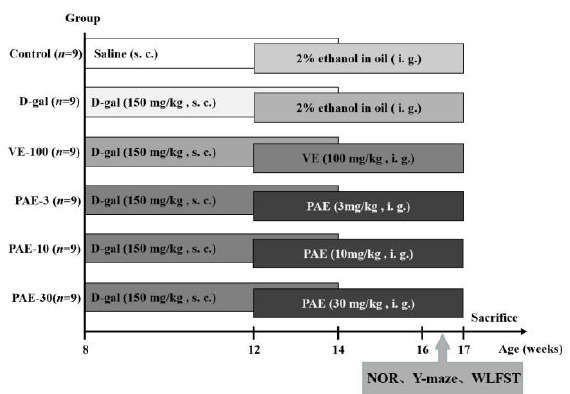
Figure 1. Experimental design and timeline.The mice were treated with once-daily d -galactose ( d -gal) (150 mg / kg) or saline by subcutaneous injection for the first six weeks. From the fifth week, the vitamin E (VE) or Physalis alkekengi (PAE) groups were subjected to VE (100 mg / kg) or PAE (at doses of 3, 10, 30 mg / kg, oral) once daily for five weeks, and the control group and model group were administered a solvent (2% ethanol in oil, oral) in the same way instead. In the ninth week, the behavior tests were investigated after PAE administration. NOR, novel object recognition; WLFST, weight-loaded swimming test. Table 1. The bioactive components of PAE.